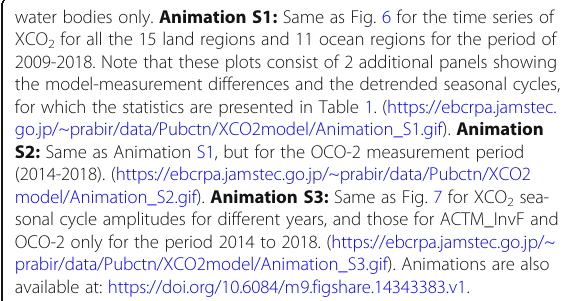
Additional file 1: Figure S1: Same as Fig. 5 but for data over land surface only. Figure S2: Same as Fig. 5, but for the observations